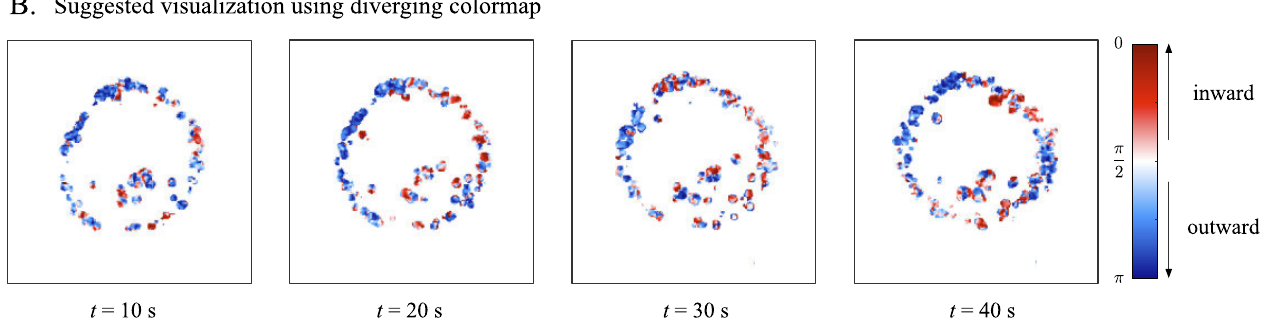
Figure 4. Comparison of visualization methods for vesicle movement in a living cell. ( A ) Conventional method using HSV (Hue, Saturation, Value) color space for optical flow. Hue indicates the orientation of optical flow vector, and saturation refers to the magnitude of the optical flow vector. ( B ) Suggested method using diverging colormap with two contrast colors. Blue color indicates the outward movement, while red color indicates inward movement with respect to the estimated cell